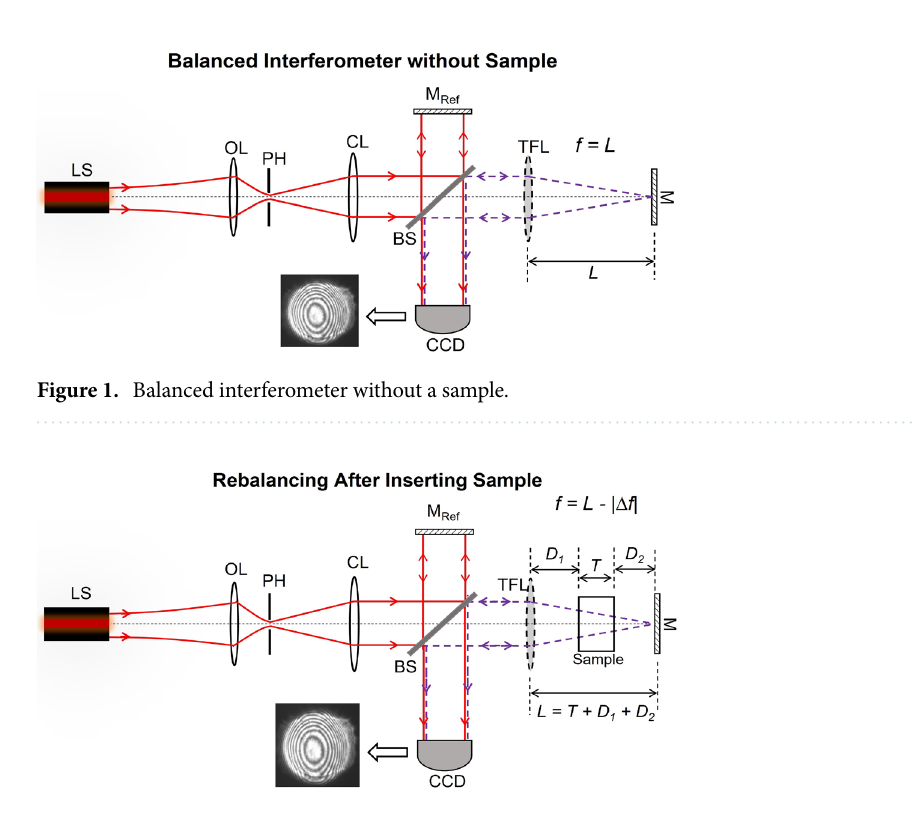
Figure 2. Rebalanced interferometer after sample